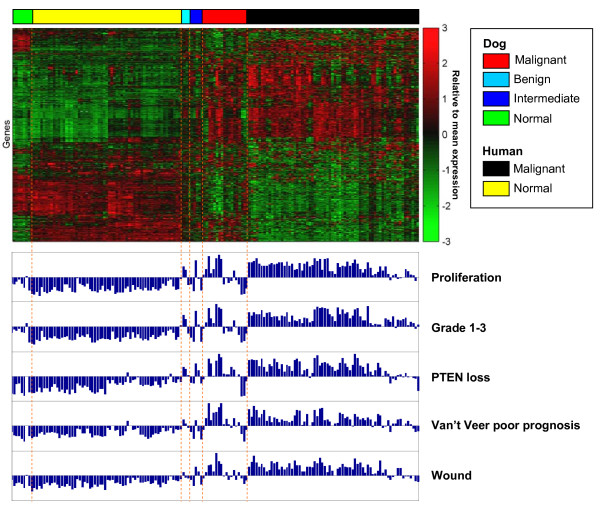
Hierarchical clustering of human-dog combined dataset. Clustering of the combined gene expression data for 33 dog (17 malignant, 5 benign and 4 intermediate) and 129 human (68 malignant and 61 normal) breast samples. A subset of 600 most variable genes was selected (see Methods for details). Samples in each class (dog normal, benign, intermediate and malignant samples, and human normal and malignant samples) were hierarchically clustered separately based on the Pearson correlation coefficients, and then columns were ordered based on class membership. Genes were hierarchically clustered based on Pearson correlation coefficients. The histograms at the bottom represent for each sample (column) the respective signature score values [37-41] (see Methods).